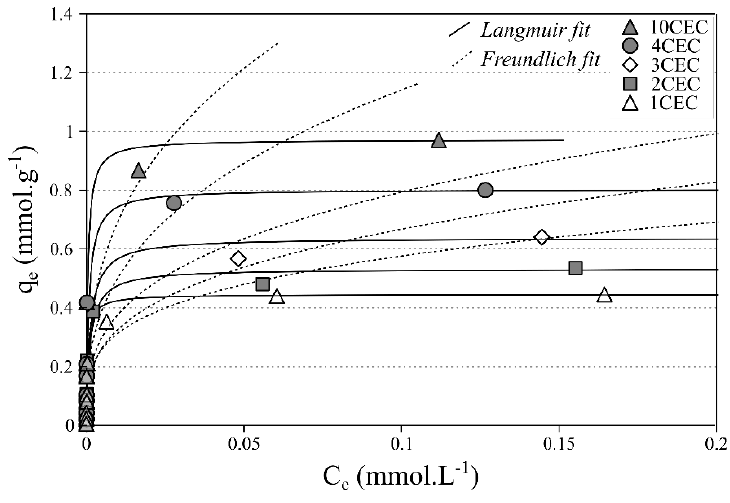
Figure 6. Single-solute adsorption isotherms at 293 K of Co 2+ onto LAP-APTES for different loads of APTES (pH = 6–6.5). APTES (pH =